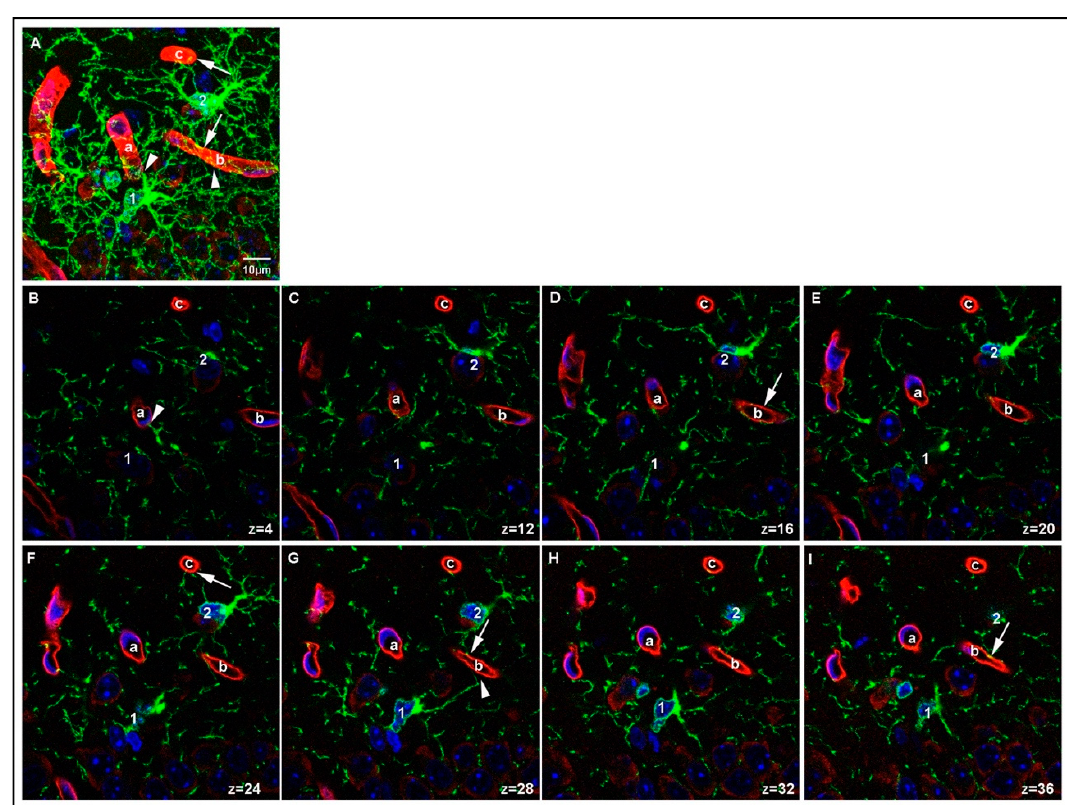
Figure 6. Details of OPC-blood vessel contacts. A region in the cortex of P15 PLP 1 h sample showing two OPCs (labeled 1 and 2 on the cell soma) contacting three different vessel segments (labeled a–c). A maximum projection of 40 z-stacks is shown in ( A ). Single z -slices (0.35 μ m depth) from the stack showing individual protrusions contacting the surface of the vessel segments are shown in ( B – I ). Arrowheads indicate contacts made by OPC 1. Arrows indicate contacts made by OPC 2. Laminin-positive vessels are shown in red, PDGFR α -positive OPCs are shown in green, DAPI staining is shown in blue, position within the z-stack is indicated for each image. Scale bar represents 10 μ m.